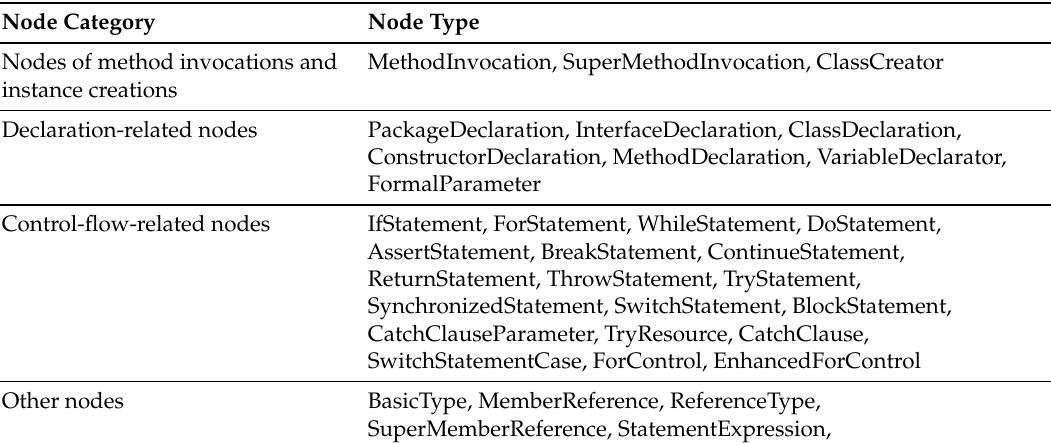
Table 1. The types of AST nodes we